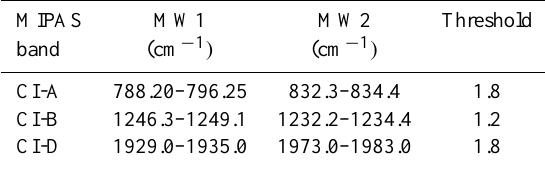
Table 1. Spectral regions of operational CI thresholds for cloud- clearing of MIPAS trace gas retrievals (Raspollini et al.,